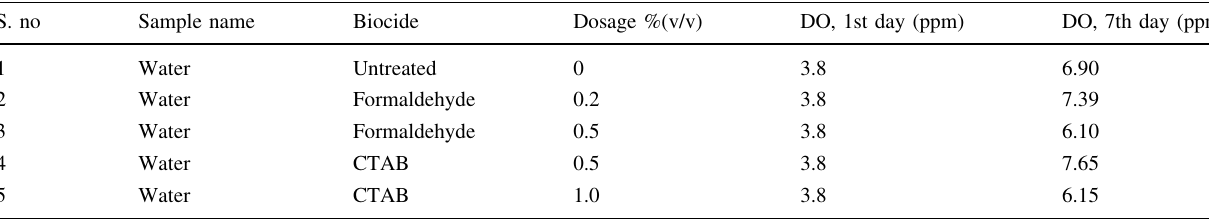
Table 4 DO measurement showing the variation in dissolved oxygen after 7 days S. no